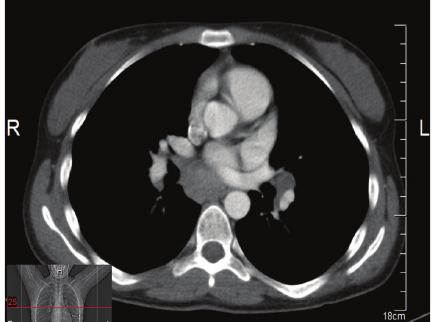
Figure 2: Thoracic CT views.